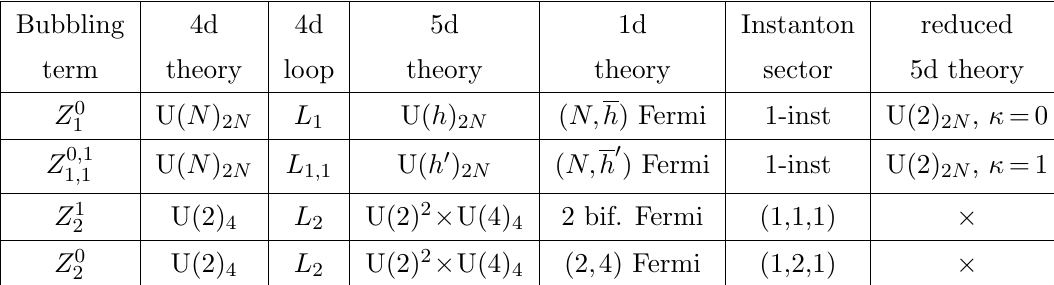
indicates a U( n ) gauge f